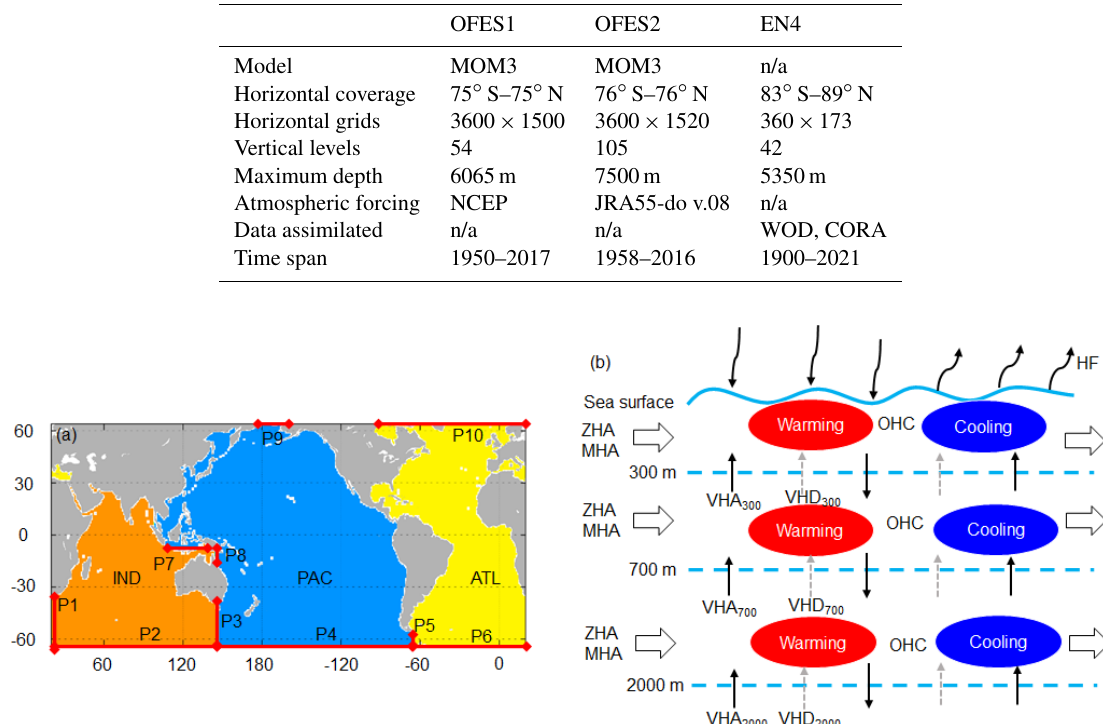
Figure 1. (a) Domains of the major basins between 64 ◦ S and 64 ◦ N, and (b) a schematic of the primary processes controlling the thermal state of an ocean. (a) PAC stands for the Pacific Ocean, ATL for the Atlantic Ocean, and IND for the Indian Ocean. The basin domain is extracted using the gcmfaces package (Forget et al., 2015) and then interpolated to the corresponding grid of each product. Gray indicates land. The solid red lines with diamond arrow stand for the water passages connecting different basins. We label it with the capital letter P (abbreviation for passage) and a serial number. The horizontal and vertical axes are longitude and latitude, respectively. (b) We use a solid light blue curve to represent the free sea surface and three dashed lines to indicate the 300, 700, and 2000m depths. The curved arrow represents the net heat flux (HF) through the ocean surface. The hollow black arrow shows the zonal (ZHA) or meridional heat advection (MHA). The thin black arrow represents the vertical heat advection (VHA), and the dashed gray arrow stands for the vertical heat diffusion (VHD). The red ellipse illustrates warming water and the blue ellipse cooling water. P1: (64–34.5 ◦ S, 20 ◦ E); P2: (64 ◦ S, 20–146.5 ◦ E);